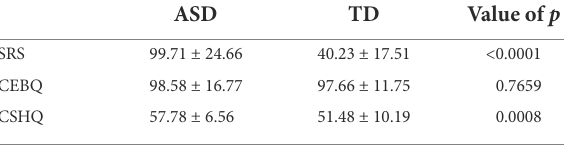
TABLE 2 Scored on eating, sleeping, and sociability.